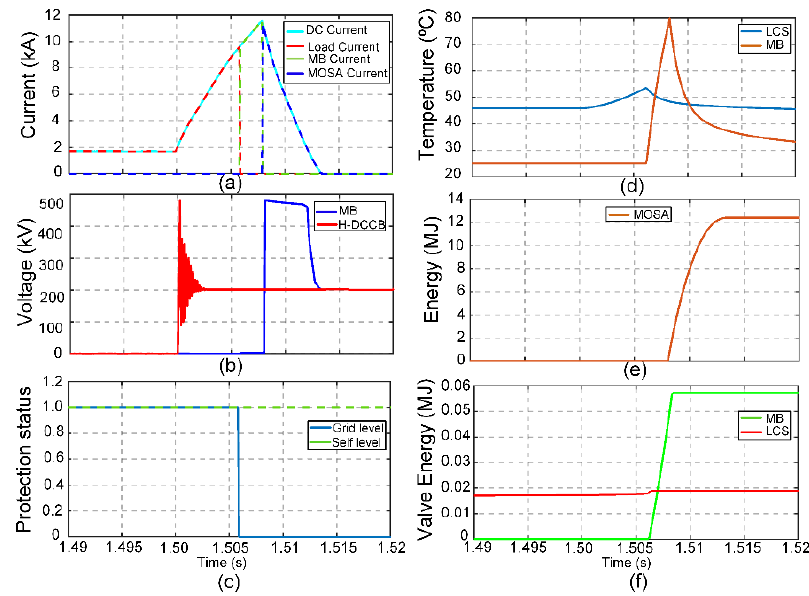
Figure 7. Low impedance fault interruption under grid-level protection, a) current b) voltage, c) protection status, d) valve temperature, e) MOSA energy, f) valve energy.